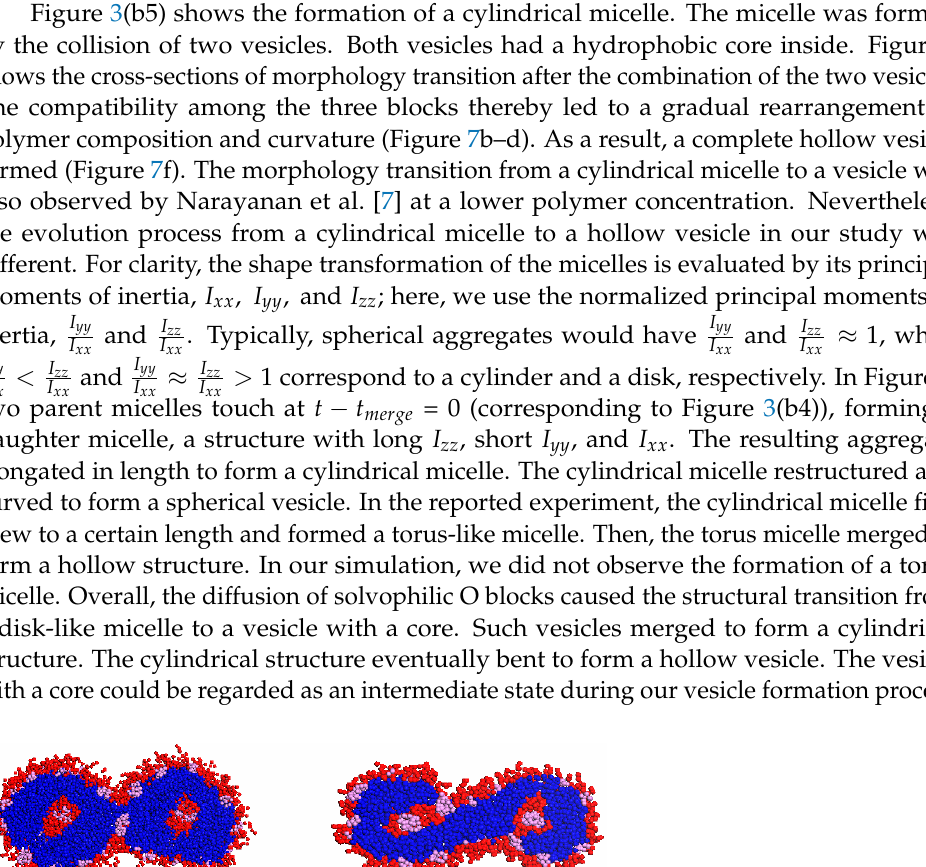
8 of 12 Figure 6. Diffusion number of solvophilic block O and solvent varies with time. 𝝓 𝑶 : number of interior solvophilic O-beads as percent of all solvophilic molecules of the structure (left); 𝝓 𝑾 : num- ber of interior solvents as percent of all molecules of the structure (right). Figure 3b5 shows the formation of a cylindrical micelle. The micelle was formed by